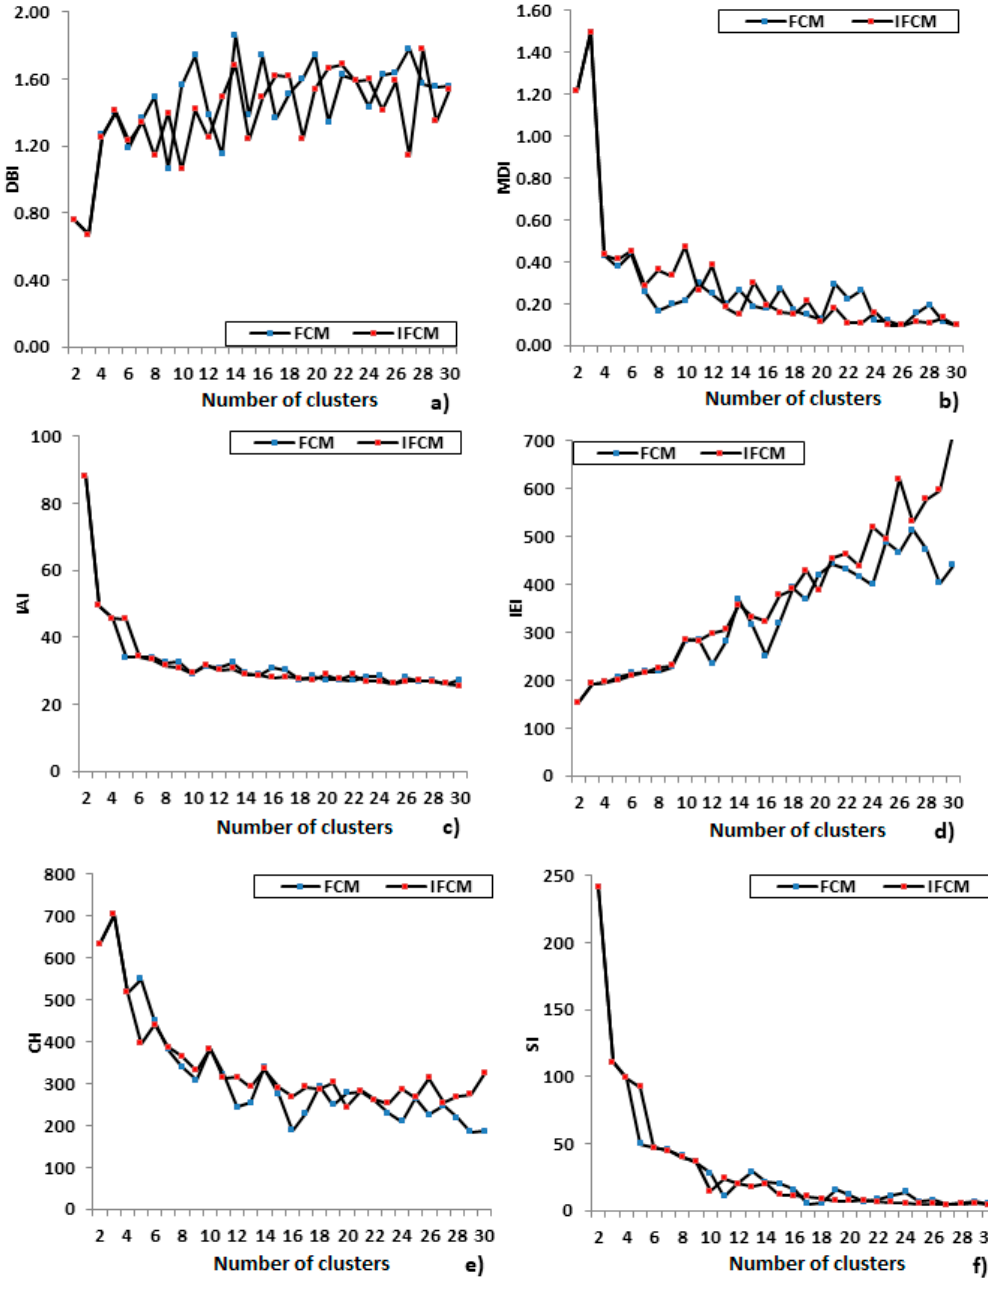
Figure 6. Comparison of the fuzzy algorithms using: ( a ) DBI, ( b ) MDI, ( c ) IAI, ( d ) IEI, ( e ) CH, ( f ) SI. Fuzzy algorithms are iterative and their operation present similarities with the K-means. defines the clusters’ composition. The increment of fuzziness parameter leads to more crisp clustering.